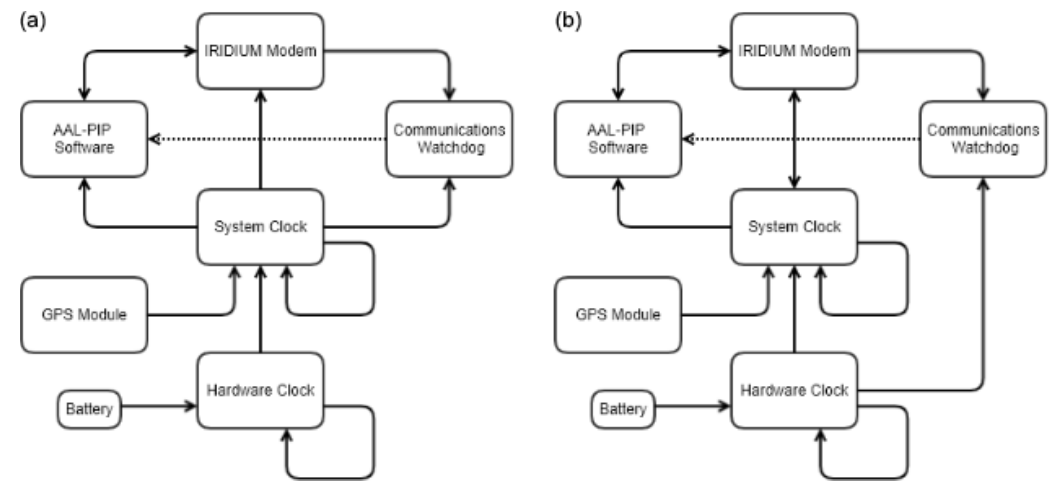
Figure 3. Diagrams contrasting the original flow of time information on the AAL-PIP systems (a) with the current method (b) . Note the use of the hardware clock as an input for the communications watchdog, as well as the availability of Iridium network sourced time for the system clock. The dotted line represents a reset signal presented by the